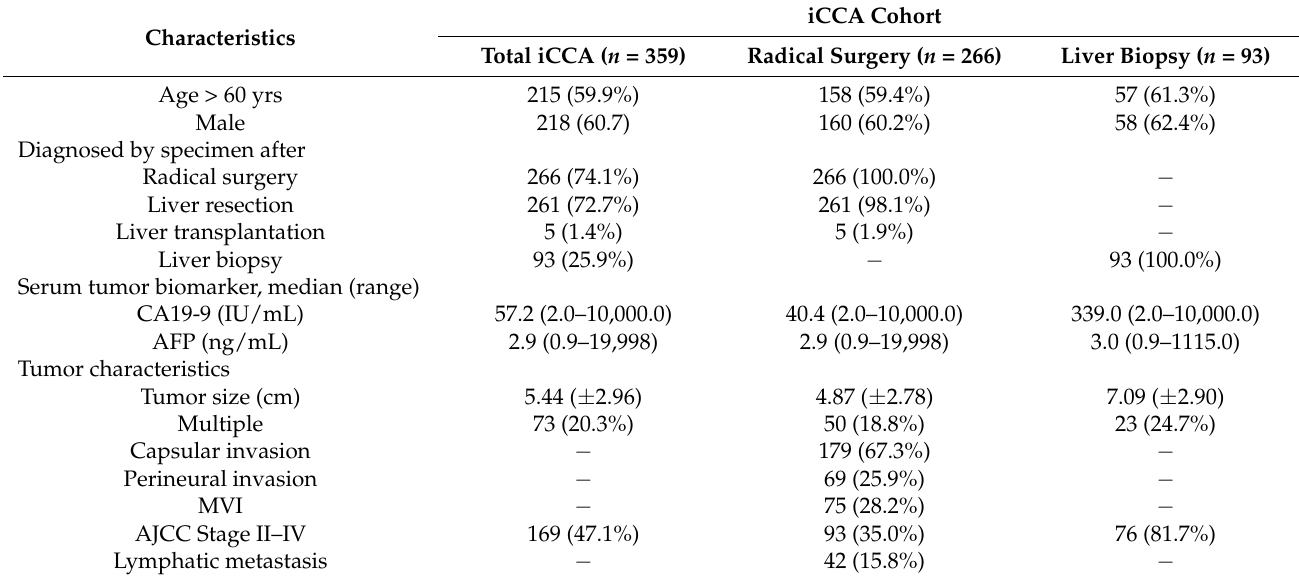
Table 1. Baseline characteristics and clinicopathological characteristics in iCCA patients